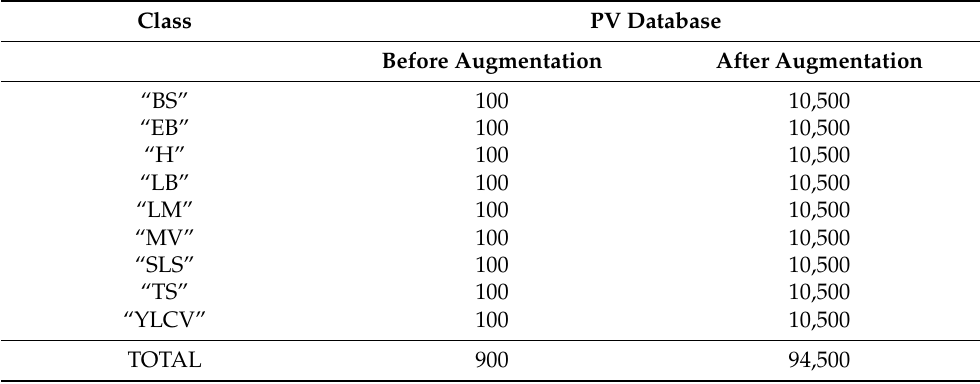
Table 2. Class-wise image data before and after augmentation of PV